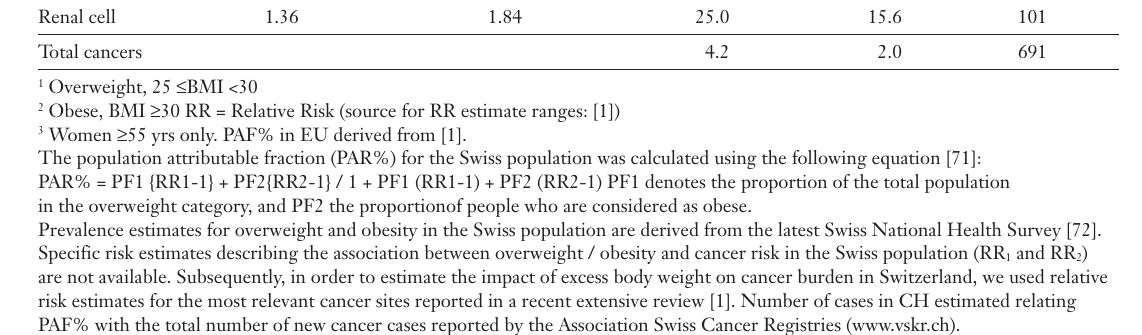
Table 1 Population attributa- ble fractions (PAF%) according to excess body weight in Eu- rope and Switzerland (incl. number of can- cer cases) for overall and site-specific can- cer incidence, based on a meta-analysis by Bergström et